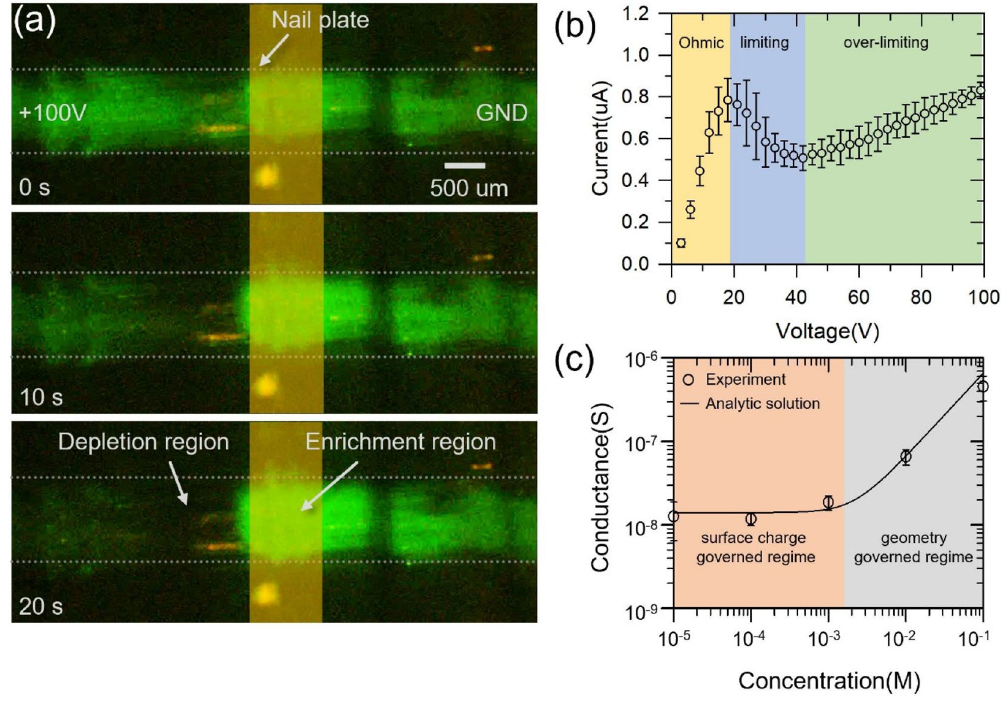
Figure 3. ( a ) The visualization of an ion depletion zone and an ion enrichment zone resulted from ICP phenomenon using nail device. ( b ) I-V characteristics of nail device. ( c ) Conductance profile of the nail device. The error bars on the plots were standard